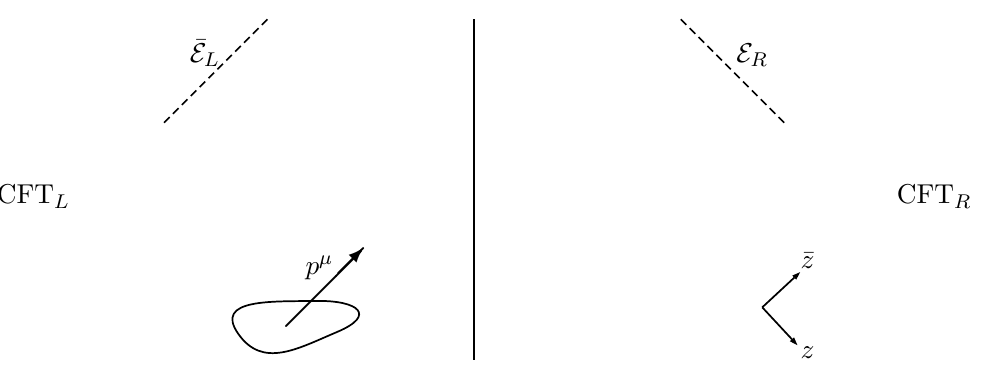
Figure 6 . The scattering experiment which de(cid:12)nes the re(cid:13)ection and transmission coe(cid:14)cients. The expectation values of the ANEC operators (cid:22) E L and E R are computed in a state created by acting with a local operator on a compact region in the far past. We may increase the size ‘ of the wave function, as long as ‘ < D , and create a state with an approximate momentum p (cid:22) . of overlaps and matrix elements, rather than of states. For instance, we can compute the limit of the norm and